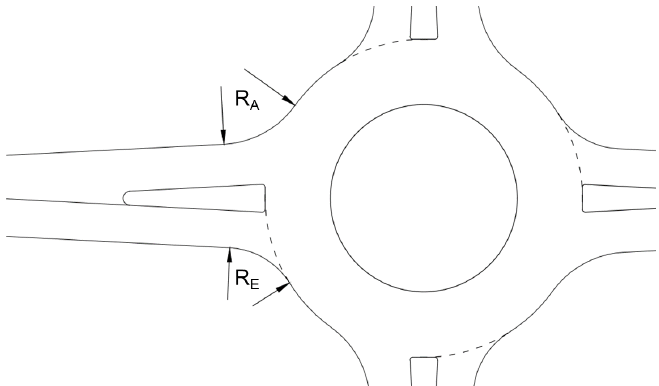
( b ) Figure 19. Entry design according to [4]: ( a ) shorter effective widening length and ( b ) longer effective widening length; “v” is the approach lane width, “m” is the splitter island length, “R v ” is the roundabout outer radius, and “R ul ” is the entry radius. Figure 20. Exit design according to [4]: “v’” is the approach lane width, “m” is the splitter island